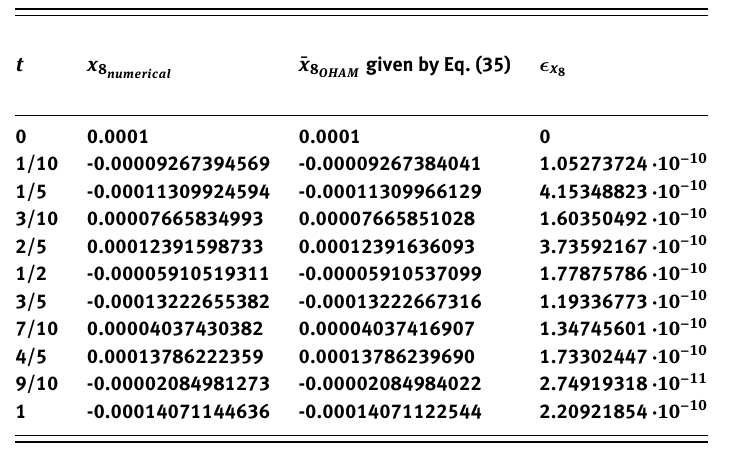
= ∣ x 8 − ¯ x 8 ∣ ) 8 OHAM numerical